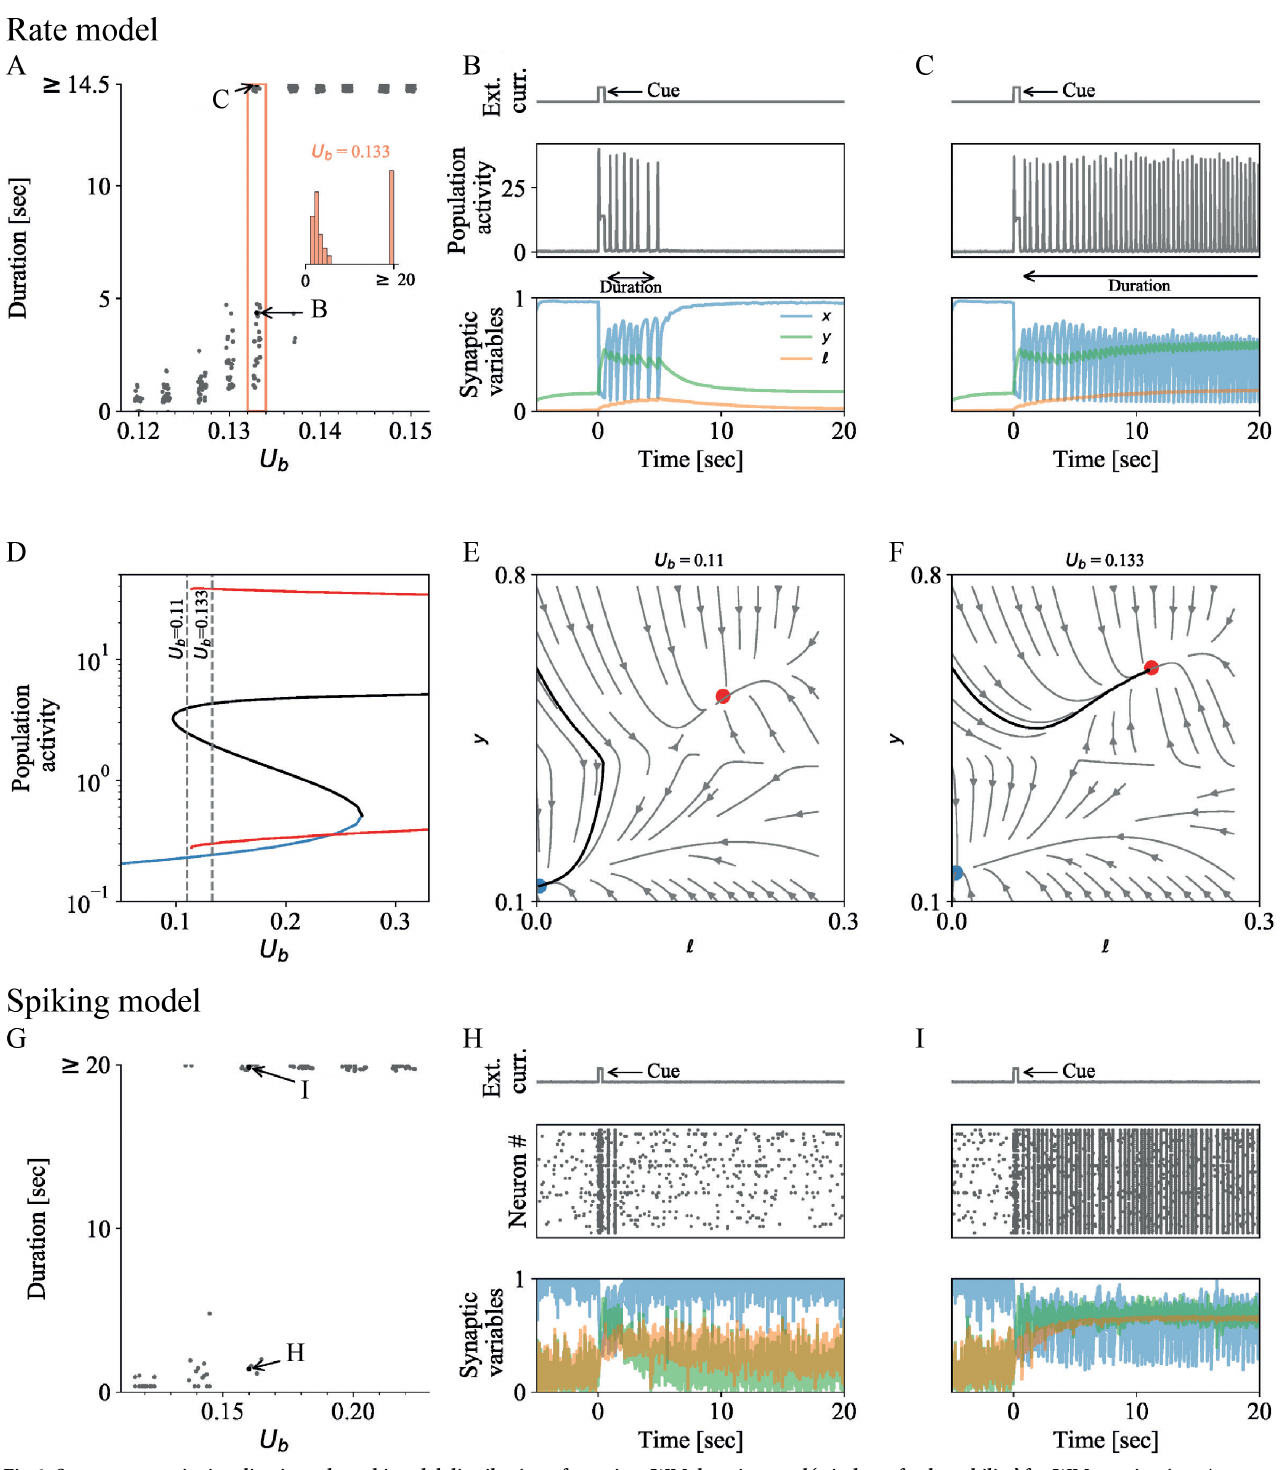
PLOS Computational Biology | https://doi.org/10.1371/journal.pcbi.1010543 October 3,